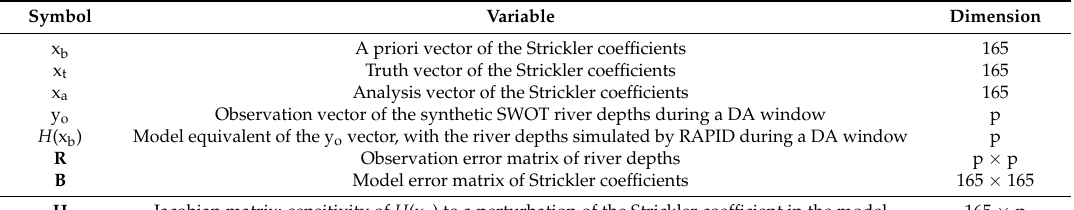
Table 2. Synthetic description of the variables used in the assimilation equations (symbol, description, and dimension). The p value corresponds to the number of SWOT observations during a DA